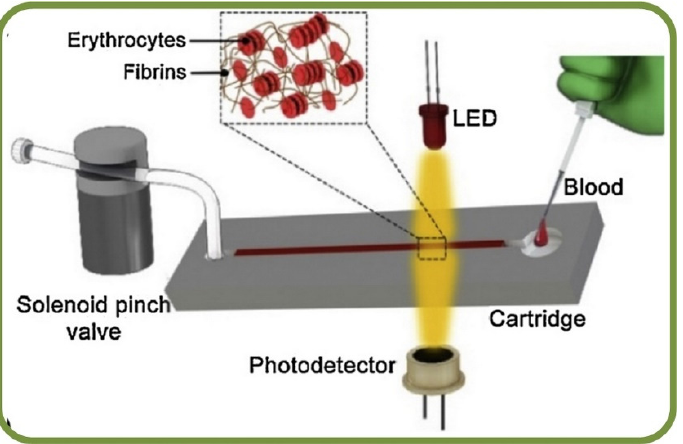
Figure 12. Optofluidic point-of-care device for the quantitative investigation of erythrocyte aggre- gation during coagulation [221].